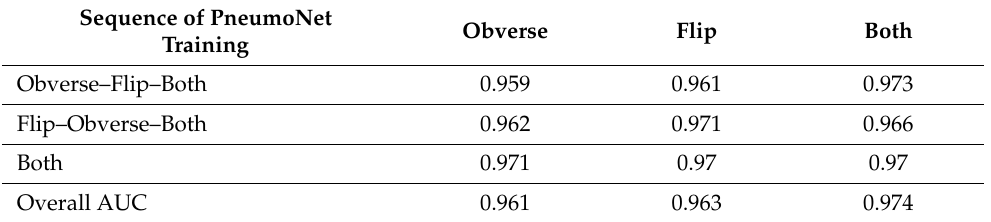
Table 7. Area under the curve values for all three sides of the input X-ray image.